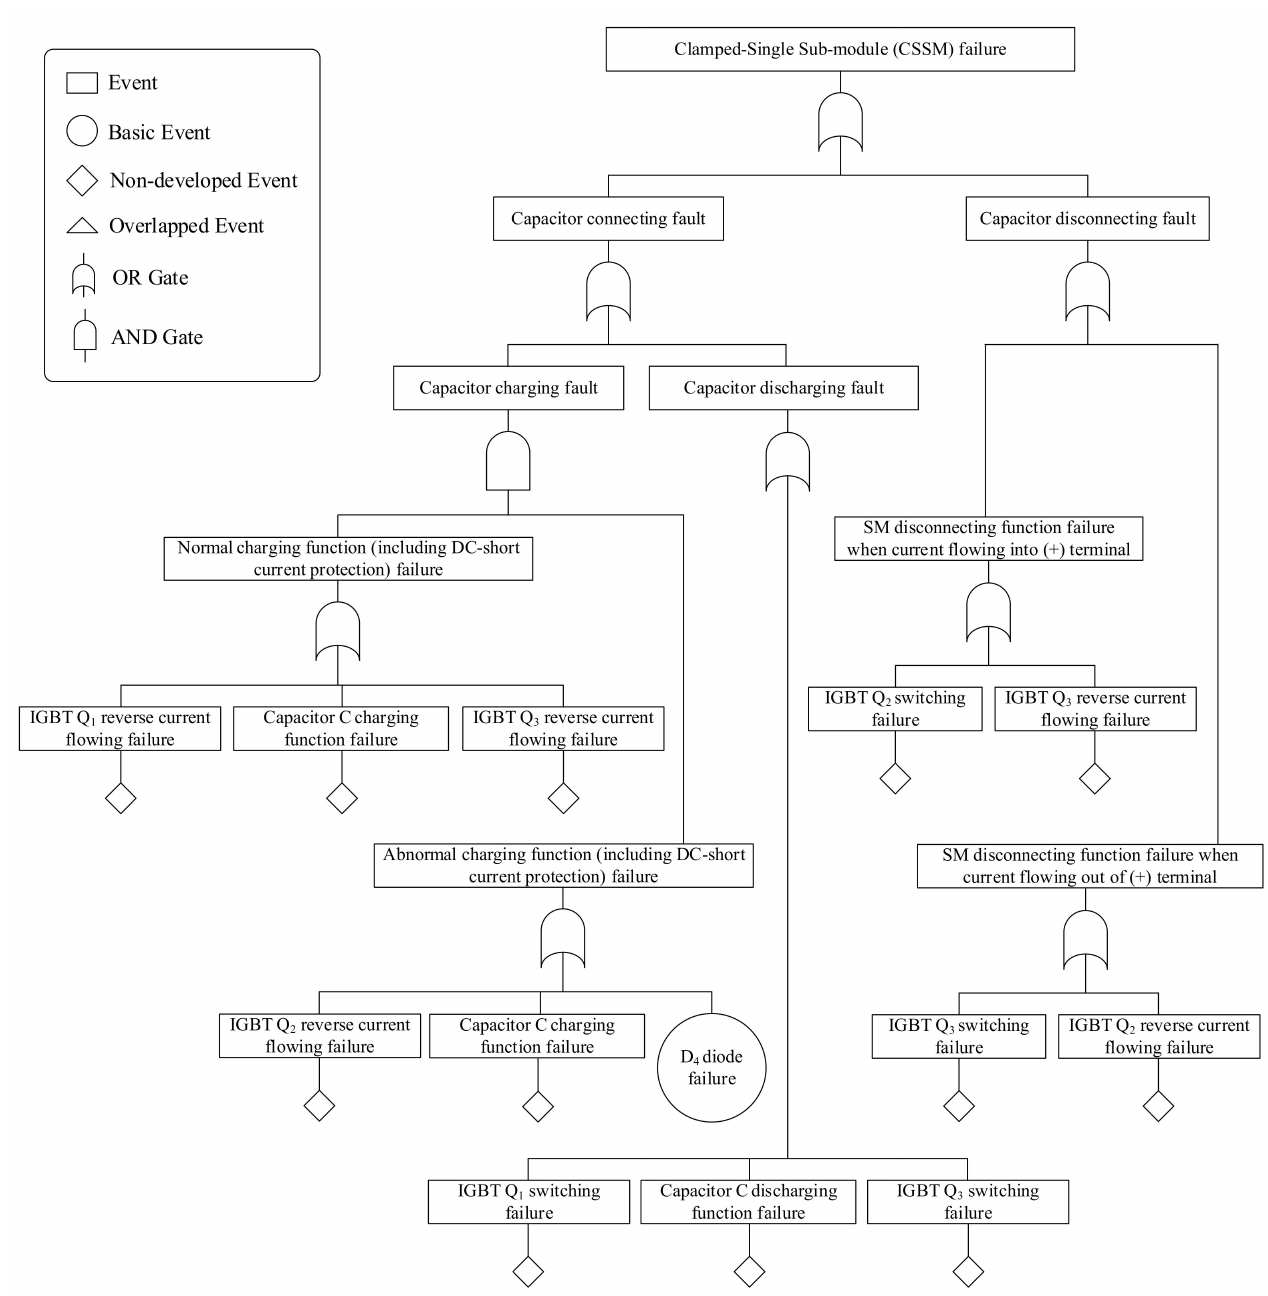
Figure 5. Main fault-tree of clamped-single